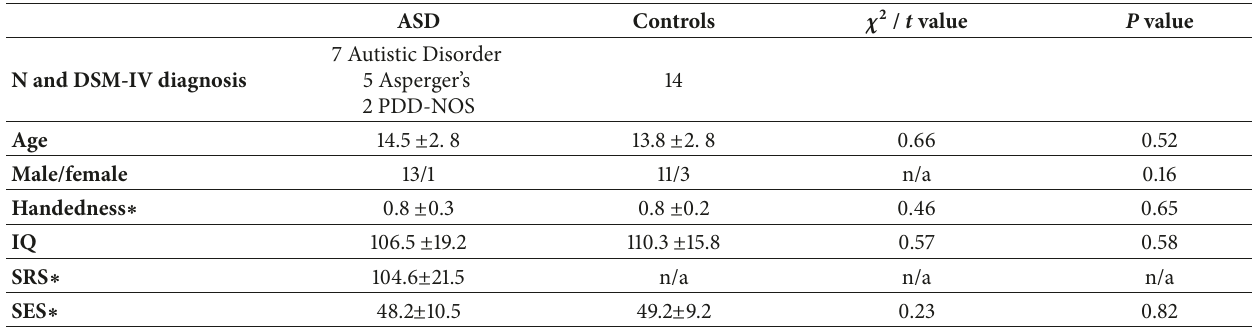
Table 1: Participants’ characteristics.